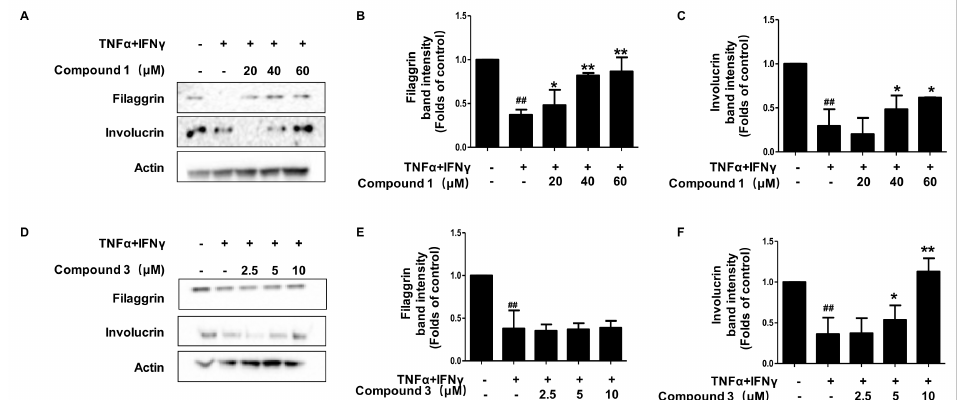
Figure 6. Effects of compounds 1 and 3 on FLG ( A – C ) and IVL ( D – F ) expression in HaCaT cells. The expressions of FLG and IVL were measured using cell lysis. The cells were pretreated with the indicated concentrations of compounds 1 and 3 for 3 h (+) or not (-), and then stimulated with TNF- α /IFN- γ (+) for 24 h. Data are represented as the mean ± SD of three independent experiments, ## p < 0.01 vs. control. * p < 0.05, ** p < 0.01, vs. TNF- α /IFN- γ -treated